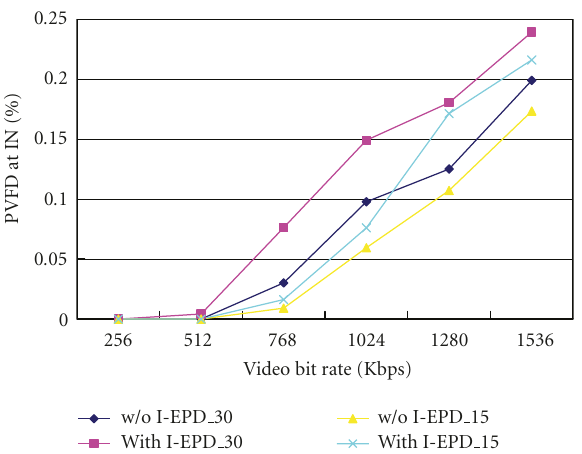
Figure 11: The variations of PSNR versus video presentation